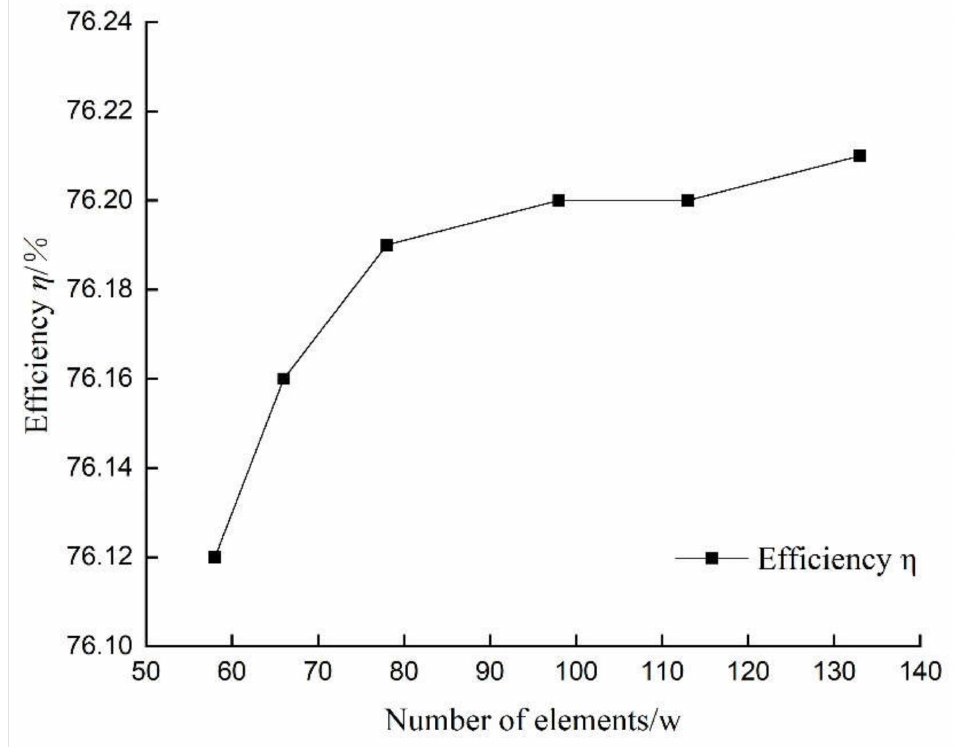
Figure 3. Grid independence